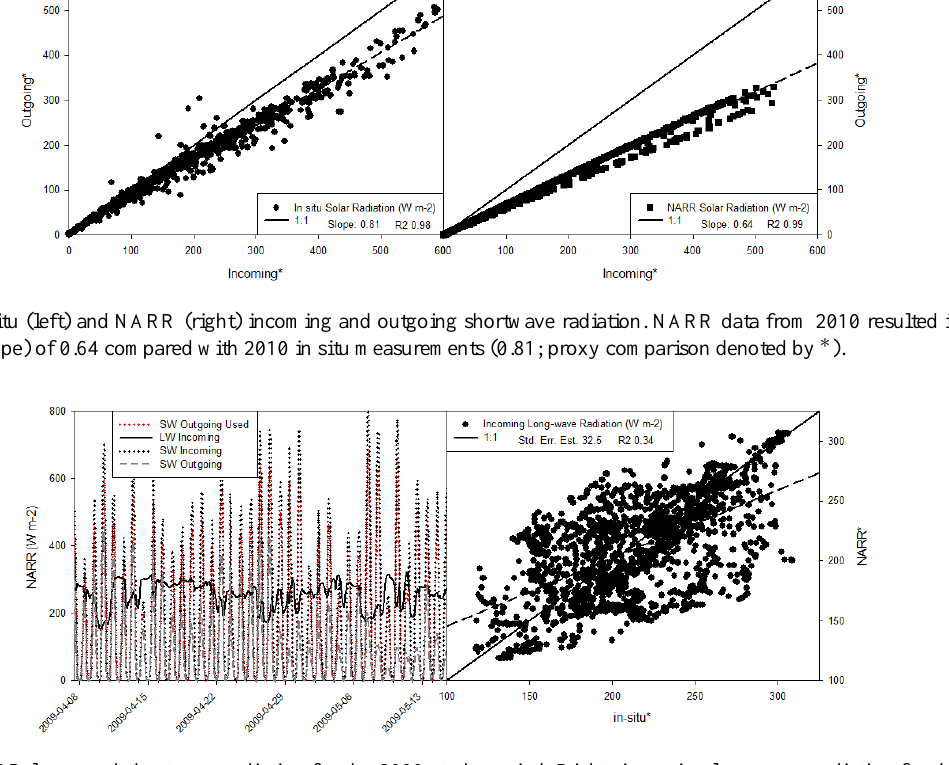
Figure 6. Left: NARR long- and shortwave radiation for the 2009 study period. Right: incoming long-wave radiation for the 2010 proxy comparison period (denoted by ∗ ).